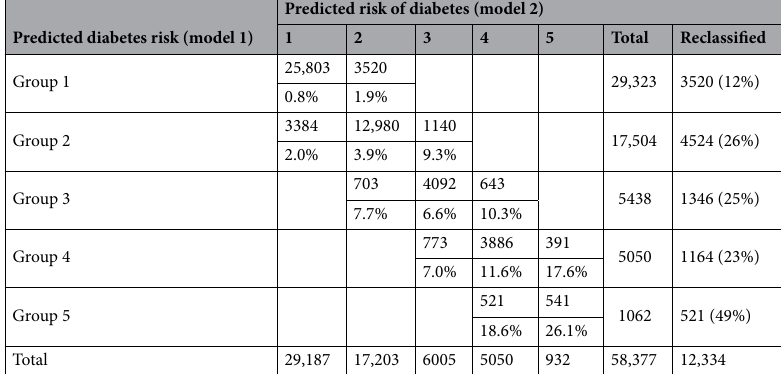
Table 4. Reclassification between risk classification according to Model 1 and Model 2.